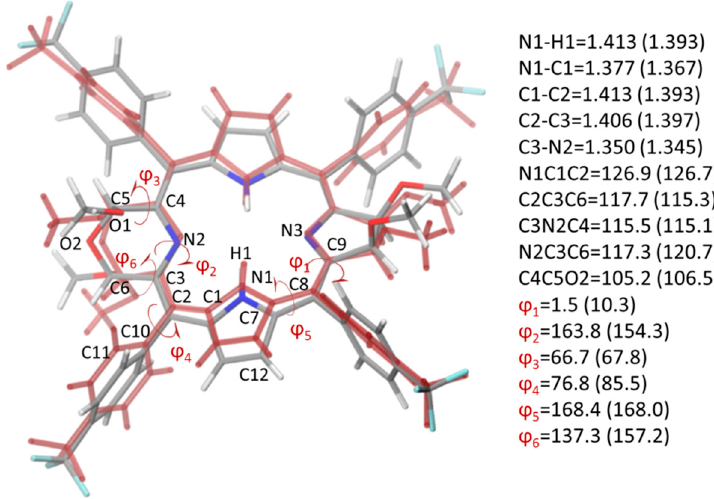
Figure 2. Superimposition of the optimized B3LYP/6-31G* and crystallographic (in red) structures of molecule 2 . Selected computed and crystallographic (in parenthesis) geometrical data, bond distances in Å and valence and torsion angles in degrees, are reported.